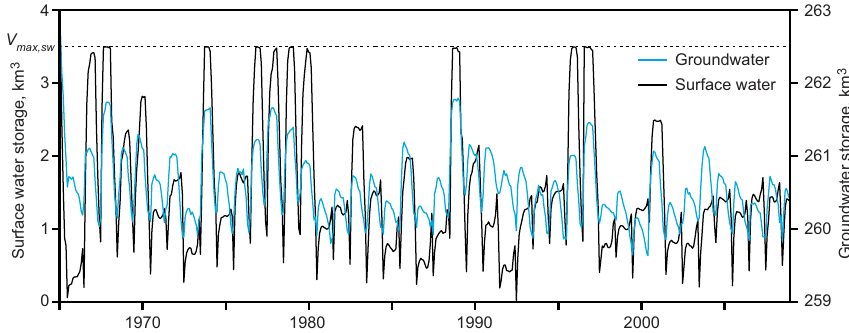
Figure 6. Simulated storage levels in the surface water reservoir and the groundwater aquifer at equilibrium groundwater storage.